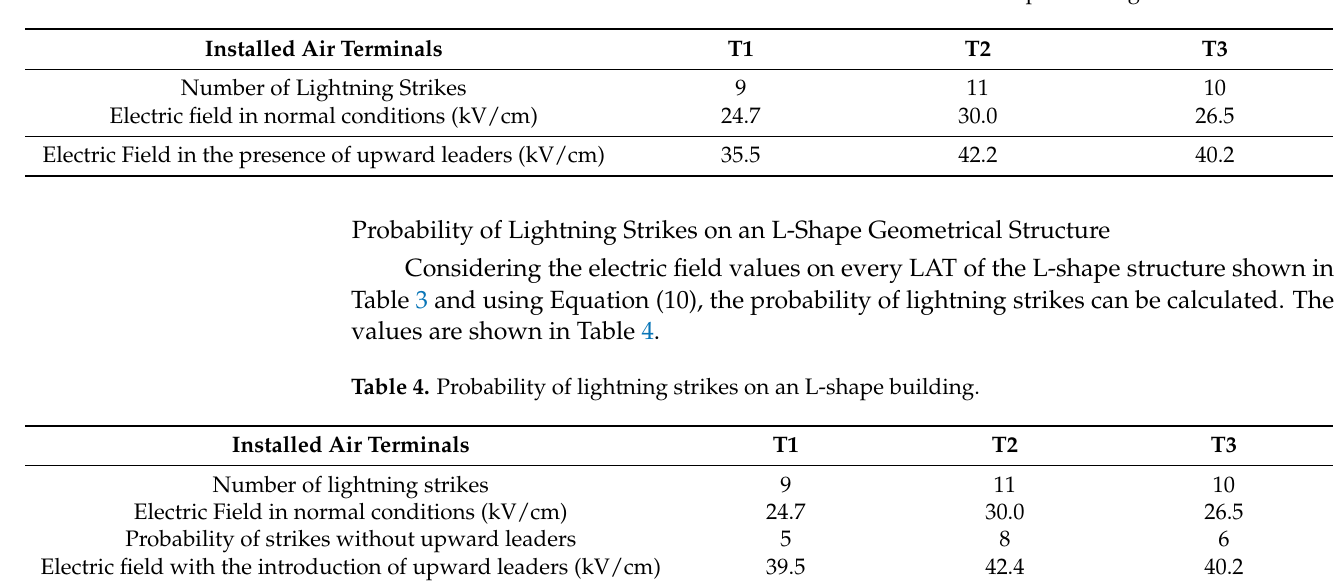
Table 3. Number of strikes and electric field on the LATs of an L-shape building.